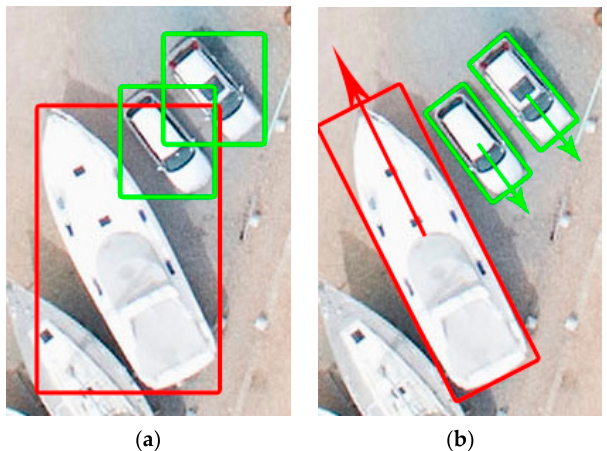
Figure 1. A comparison between traditional bounding box and inclined bounding box. ( a ) the traditional bounding box. ( b ) the inclined bounding box.